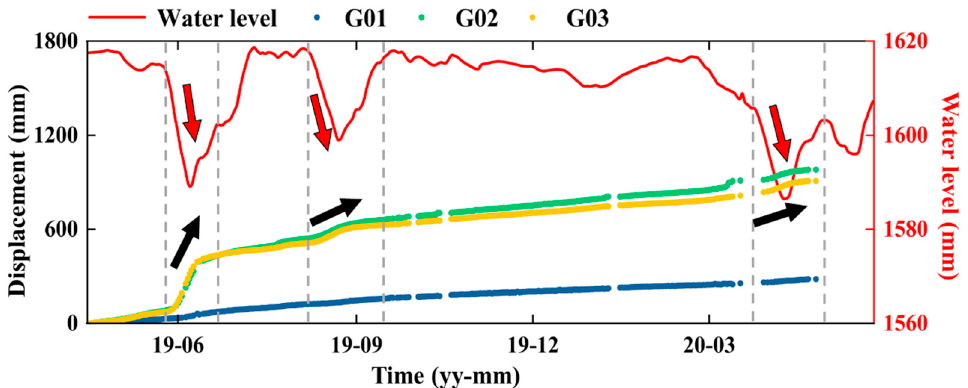
Figure 11. Time-series of cumulative displacement at G01, G02, and G03 and the change in reservoir water level.